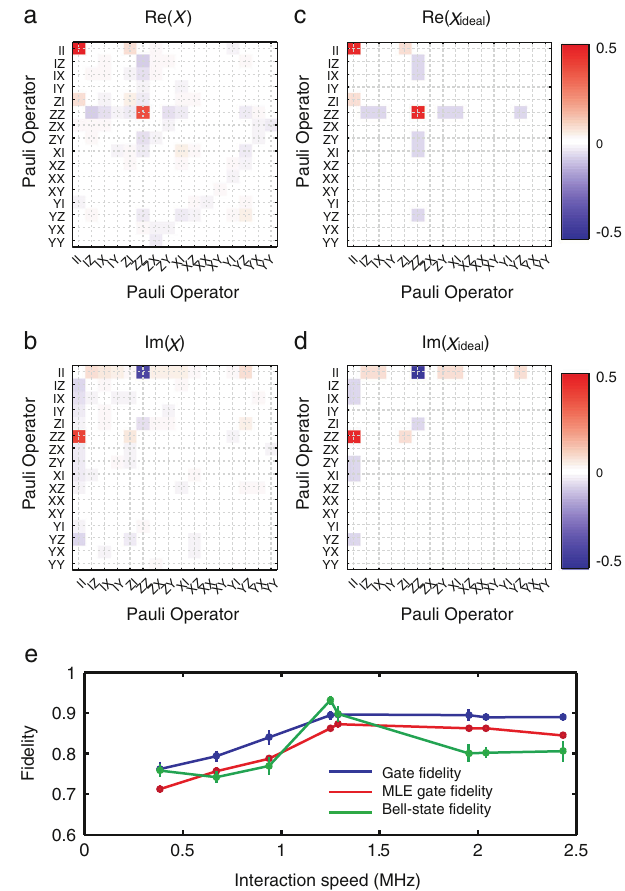
Fig. 4 Process tomography for the two-qubit entangling gate. a Real component of the measured process matrix. b Imaginary component of the measured process matrix. c Real component of the ideal process matrix. d Imaginary component of the ideal process matrix. e Gate fi delity of the measured process matrix and most-likely completely positive process matrix and two-qubit Bell state fi delity as a function of interaction strength. Error bars are statistical